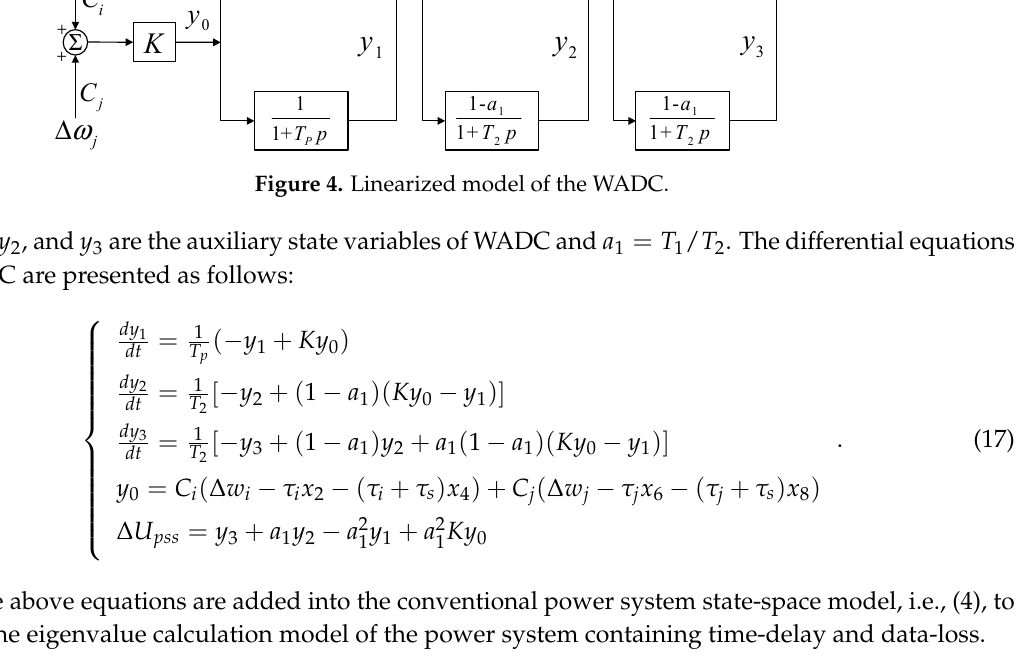
Figure 3. Diagram of the power system stabilizer (PSS) transfer function.